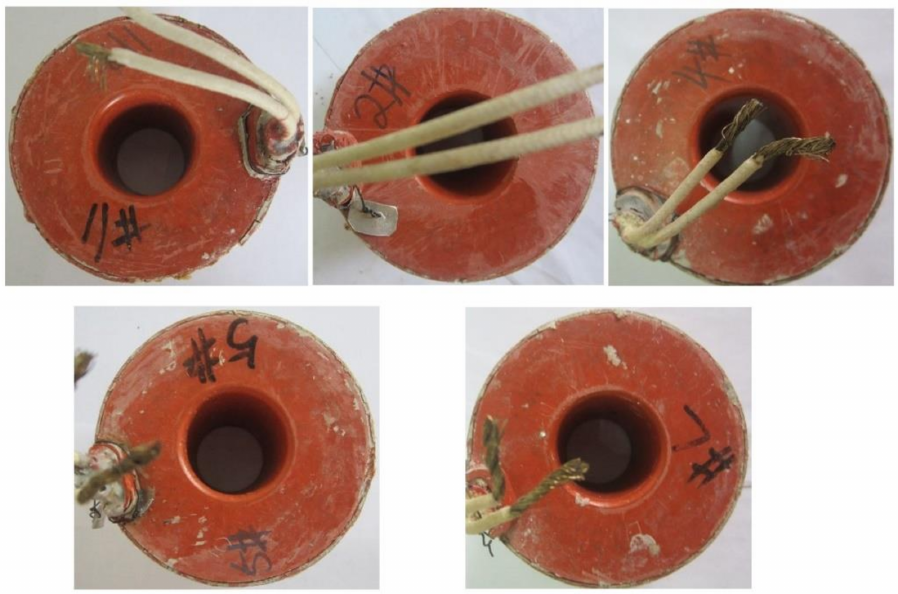
Figure 12. The coil assemblies after 7 days of heat exposure at 310 ◦